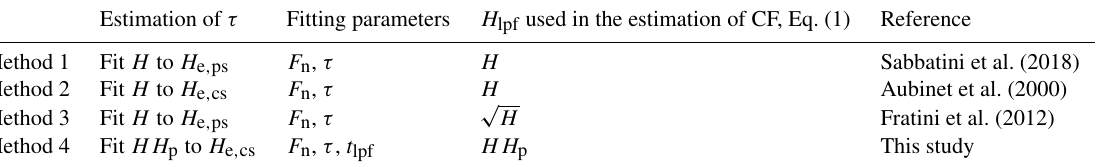
Table 1. Methods used in this study to estimate flux losses and related correction factors (CFs) due to low-pass filtering of the scalar signal. See the definitions for H and H p in Eqs. (5) and (6), respectively. Values for τ (and t lpf in Method 4) were estimated with non-linear least squares fit to H e , ps or H e , cs , in which F n and τ (and t lpf in Method 4) were used as fitting parameters. The additional normalisation factor F n took into account any inaccuracies in estimation of variances and covariances in the calculation of H e , ps and H e , cs (Eqs. 13 and 12), respectively. The fits were weighted with temperature cospectra in order to give more weight to frequencies where the scalar fluxes were high.